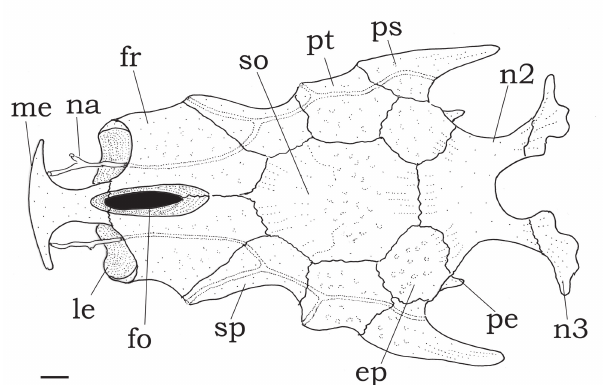
Fig. 2. Neurocranium of Centromochlus britskii , MZUSP 43251, paratype, 35.9 mm SL. Dorsal view. Abbreviations: ep , epioccipital; fo , cranial fontanel, fr , frontal; le , lateral ethmoid; me , mesethmoid; na , nasal; n2 , second nuchal plate; n3 , third nuchal plate; pe , posterior epioccipital process; ps , posttemporal-supracleitrum; pt , pterotic; so , supraoccipital; sp , sphenotic. Scale bar =1 mm.